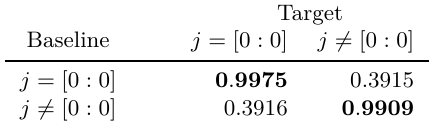
Table 5: Average PCCs between baselines and target traces ( N = 1 ,